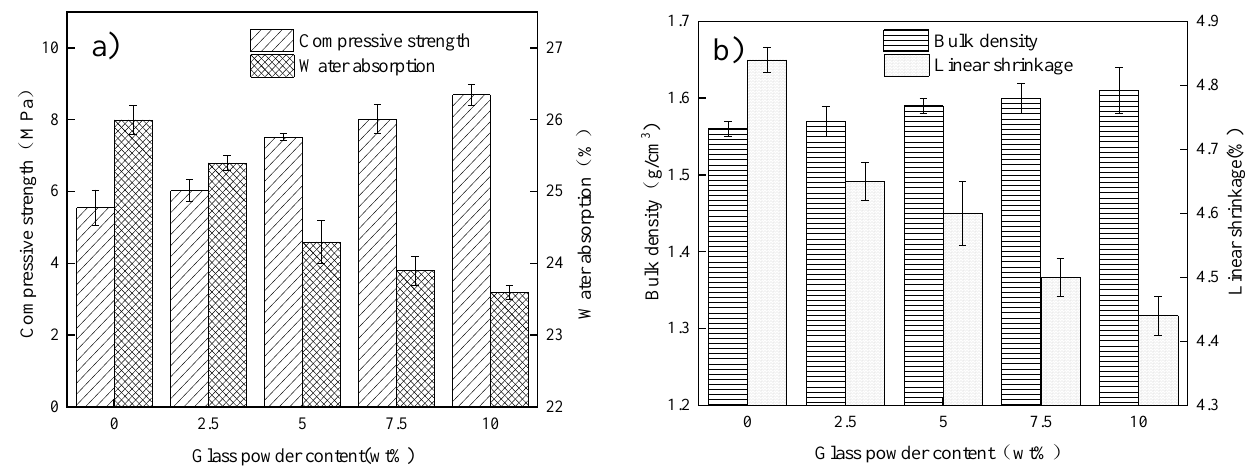
Figure 6. Effect of glass powder content on the characteristics of sintered brick: ( a ) compressive strength and water absorption; ( b ) bulk density and sintering shrinkage.